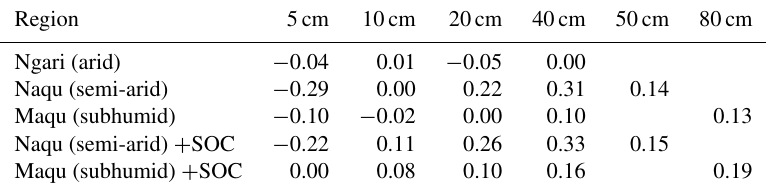
Table A5. Biases of C s between estimates, based on the De Vries (1963) model across the three climate zones, and the measurements. The upper part of the table lists the bias derived from estimations without considering SOC impact, and the lower part of the table lists the biases from estimations taking SOC impact into account in the Maqu and Naqu regions. The unit of listed value is MJm − 3 K − 1 . Region 5cm